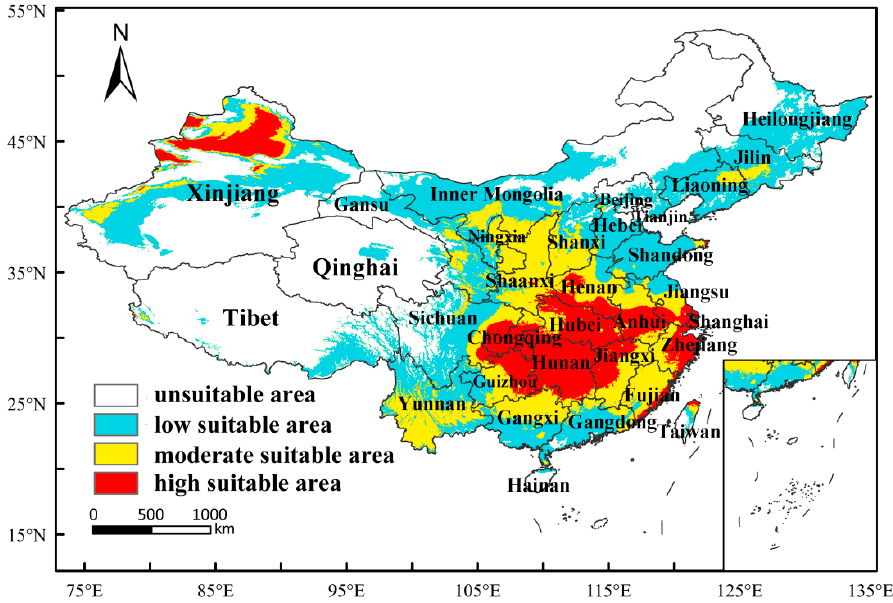
Figure 6. Predicted potential distribution of M. destructor in China under the current climatic conditions.